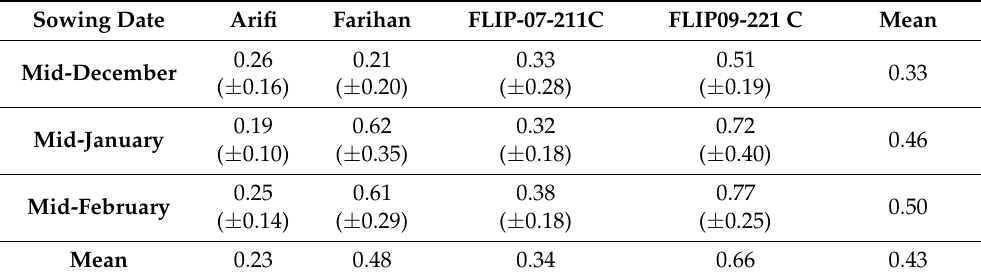
Table 5. Effects of sowing date and chickpea genotypes on the mean rate of diseases progress ± SD, 2017–2018 cropping seasons.